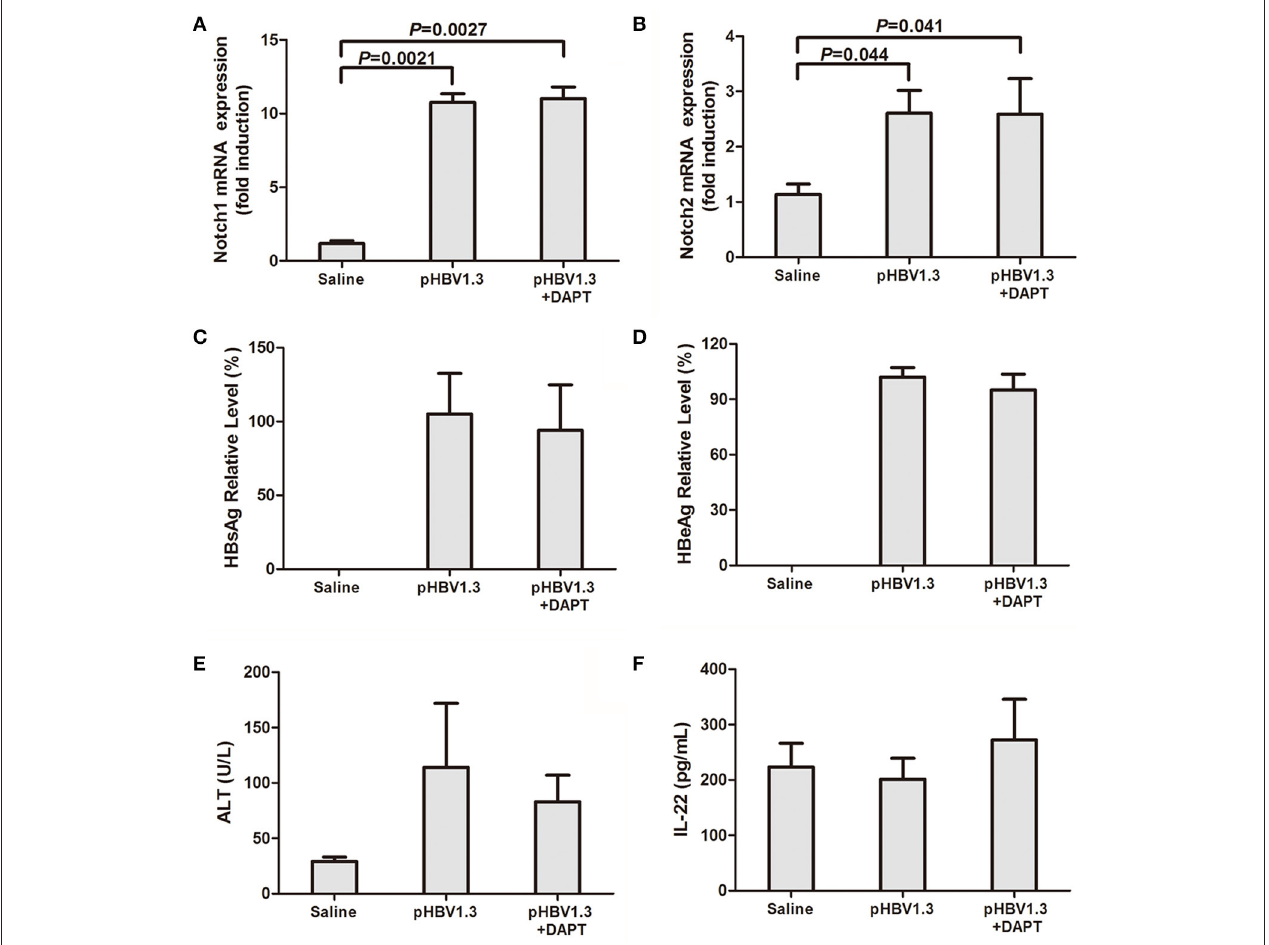
FIGURE 1 | Inhibition of Notch signaling did not affect HBV antigens production but reduced liver injury. Mice (4 per group) were hydrodynamically injected with saline, pHBV1.3 plasmid, or pHBV1.3 plus γ -secretase inhibitor DAPT. Mice were scarified 96h post injection. Livers and serum were harvested for analysis. mRNA expressions corresponding to Notch1 (A) and Notch2 (B) in the livers were measured by PT-PCR. Results are displayed as fold differences relative to the saline injection group, and normalized to β -actin. HBsAg (C) and HBeAg (D) in the serum were measured by electro-chemiluminescence. (E) Serum ALT levels were measured by Infinity ALT reagent. (F) IL-22 concentrations in the serum were tested by ELISA. All values are presented as the average from each group, and error bars represent